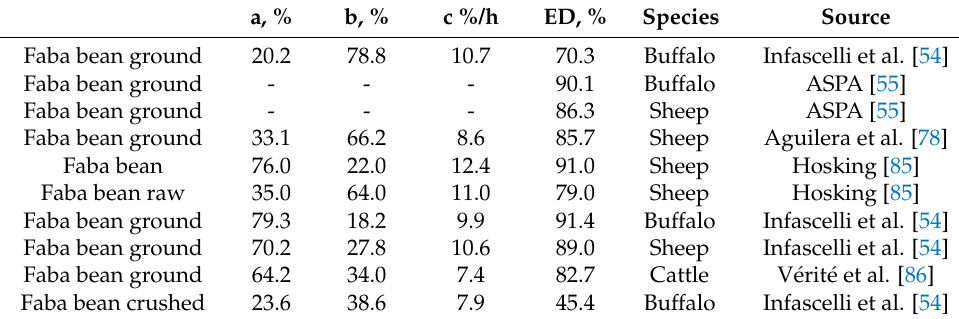
Table 6. Protein degradability of raw and treated faba bean